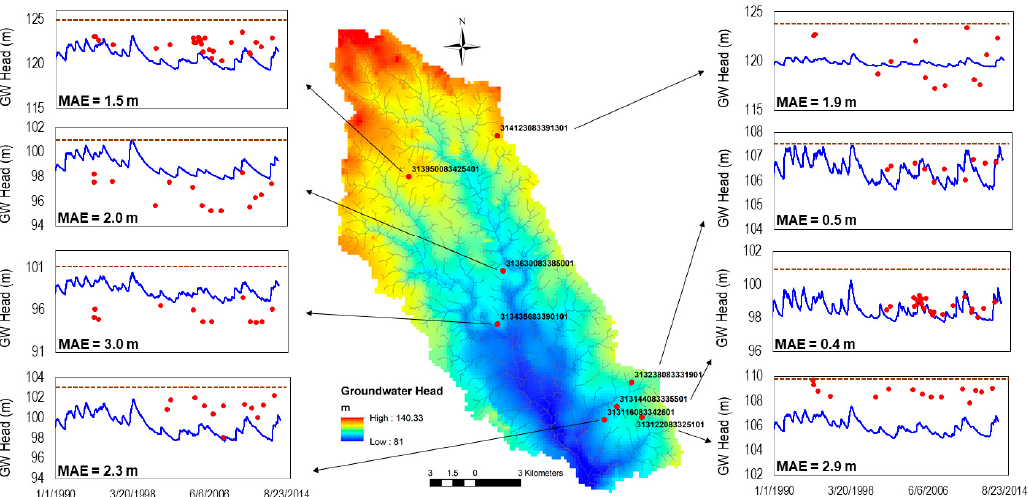
Figure 12. Map of groundwater head (m) for each grid cell at the end of the simulation period, and time series of daily simulated groundwater head (m) and periodically observed groundwater head (m) for the eight USGS groundwater monitoring well locations (see Figure 6). The dotted brown line on each time series chart represents the ground surface at that site. MAE = Mean Absolute Error (m), i.e., the average residual between the observed and simulated groundwater head values. The mean absolute error (MAE) of simulated head values that correspond in location and timing to measured head values is 1.7 m. All sites have an MAE of 3.0 m or less. Two locations (313144083335501, 313238083331901) show excellent tracking of the measured head by the model, while others show moderate agreement. For several locations, the model underpredicts head levels,